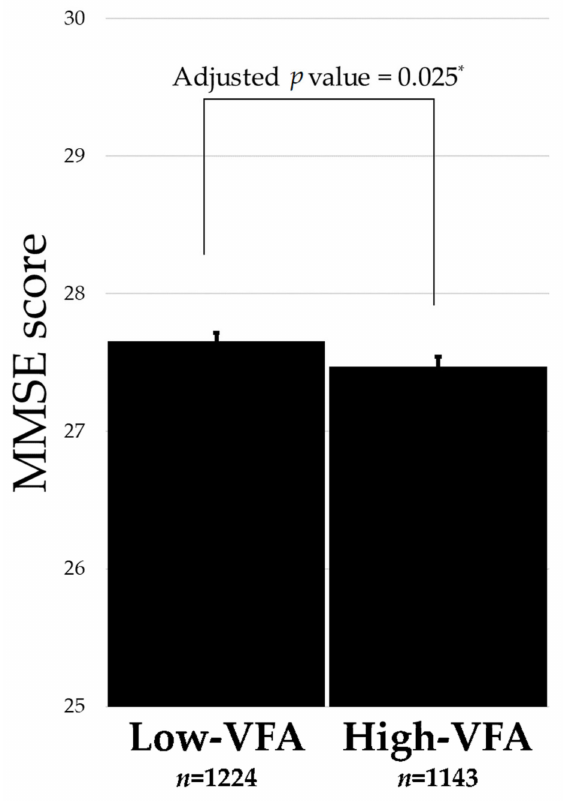
Figure 2. Association between cognitive function and VFA using the mini-mental state examination (MMSE). The p value was calculated by analysis of variance for a linear regression model with the MMSE score as an objective variable, and covariates such as VFA, age, sex, muscle mass, education, smoking, body mass index, exercise habits, alcohol consumption, and prevalent confounding disease (depression, hypertension, hyperlipidemia, and diabetes). * p <